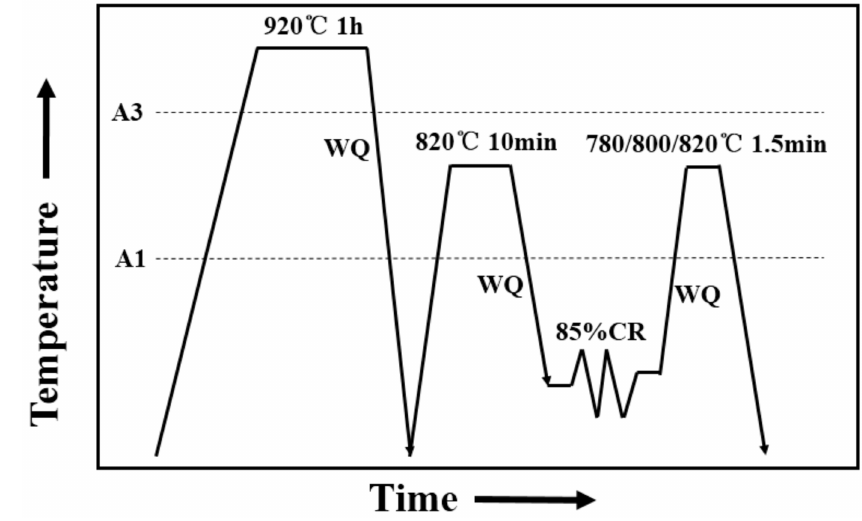
Figure 1. Thermomechanical cycle used to produce UFG-DP steels.A1 and A3: austenite formation’s start and finish temperatures during heating respectively; WQ: water quench; CR: cold